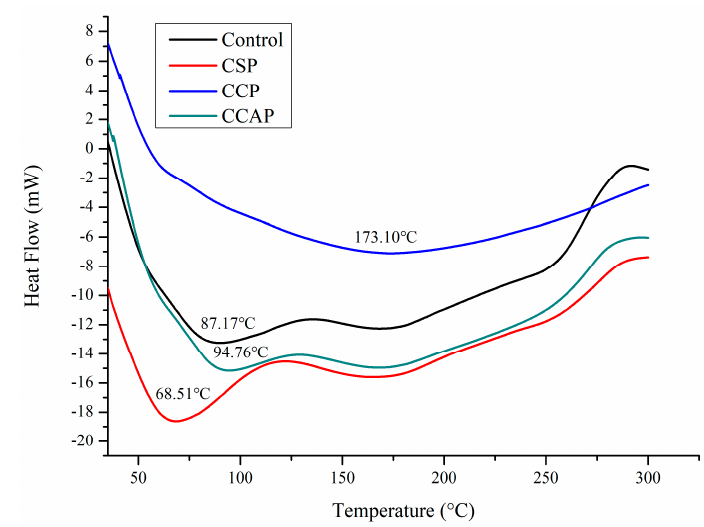
Figure 7. DSC curves of chitosan (control) and peptide − containing films. CSP: films from chitosan and soy protein peptides; CCP: films from chitosan and corn protein peptides; CCAP: films from chitosan and casein peptides.